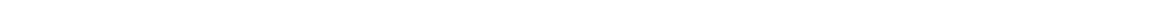
Fig. 4. Isolated elements assigned to a pike Esox nogaicus sp. nov. from Southeastern Europe, Nogaisk; Pleistocene. A . Holotype, right dentary (NMNHU-P 27/1697), occlusal (A 1 ) and lateral (A 1 ) views. B . Left frontal (NMNHU-P 27/1124), lateral view. C . Left parietal (NMNHU-P 27/1129), dor- sal view. D . Vomer (NMNHU-P 27/1088), ventral view. E . Parasphenoid (NMNHU-P 27/1047), ventral (E 1 ) and dorsal (E 2 ) views. F . Left hyomandibular (NMNHU-P 27/1093), lateral (F 1 ) and medial (F 2 ) views. G . Left maxilla (NMNHU-P 27/1036), lateral view. H . Right articular (NMNHU-P 27/1024), medial view. I . Right palatine (NMNHU-P 27/1115), ventral (I 1 ), lateral (I 2 ), and dorsal (I 3 ) views. J . Right opercular (NMNHU-P 27/986), medial view. K . Left ceratohyal (NMNHU-P 27/1059), medial view. L . Right quadrate (NMNHU-P 27/1012), medial view. M . Left cleithrum (NMNHU-P 27/1035), medial view. A 2 , G, H, I 1 , I 2 , M, anterior to right; A 1 , B, I 3 , J, L, anterior to left; C–F, K, anterior towards top. Scale bars 5